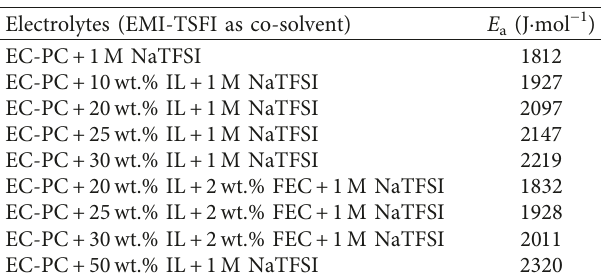
Figure 3: Plots of ionic conductivity versus temperature of EC-PC Table 2: The activation energy of the mixed electrolytes EC-PC (1: 1)+ x wt.% EMI-TFSI+1 M